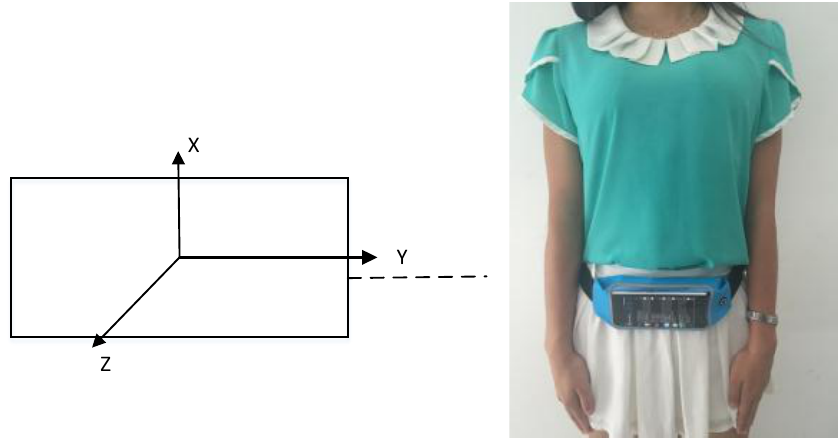
Figure 5. Smartphone’s coordinate system and positioning.